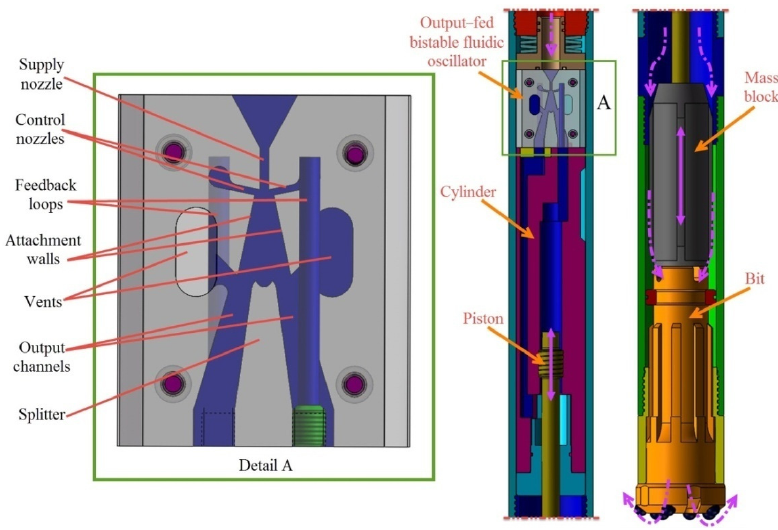
Figure 2. A 3D schematic of the fluidic hammer and the output ‐ fed bistable fluidic oscillator.